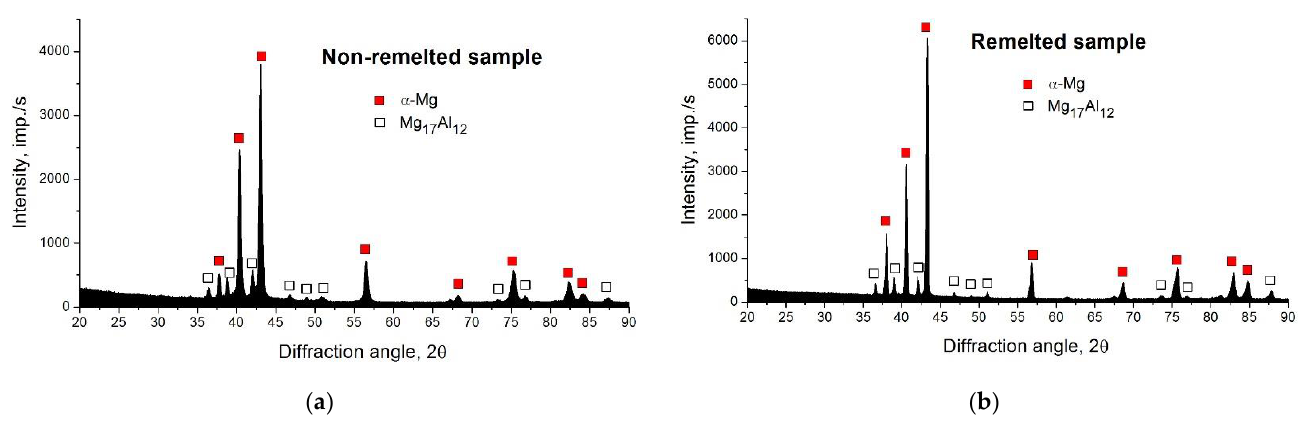
Figure 3. XRD patterns of non-remelted ( a ) and remelted ( b ) samples. The microscopic observations of the remelted samples revealed essential changes in the surface layer microstructure in comparison to the core microstructure (Figure 4). Strong refinement of the microstructure and more even distribution of the individual phases were the main components of the observed microstructural changes. Very fine α phase dendrites dominated in the remelting zone. The dendritic arm spacing in the GTAW remelted surface was in the range of 3 – 10 μ m. In the interdendritic spaces, the presence of β -phase precipitates was also found, which formed a fine network.